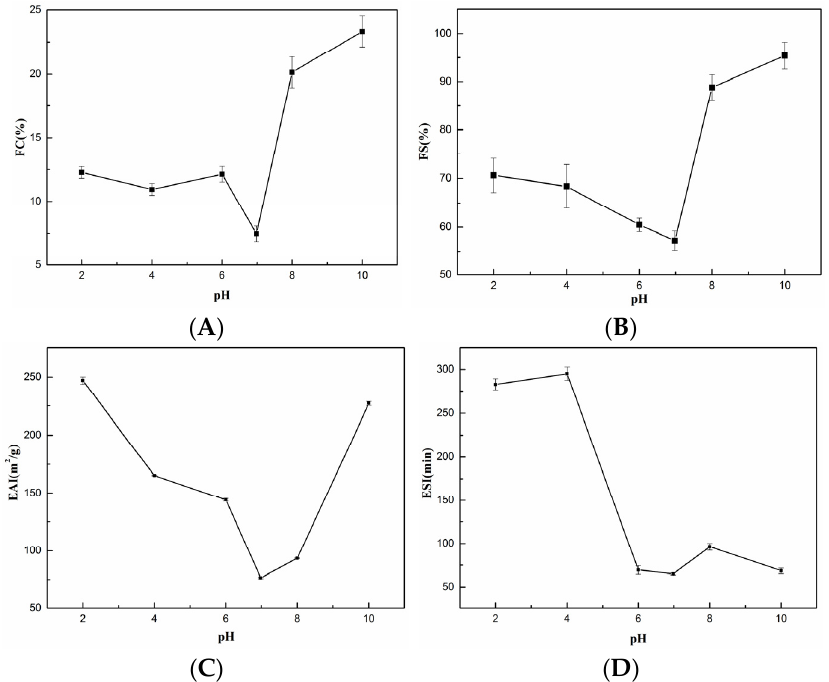
Figure 6. Functional properties of SCSC. ( A ) Foam capacity (FC); ( B ) foam stability (FS); ( C ) emulsifying activity index (EAI); ( D ) emulsion stability index (ESI).